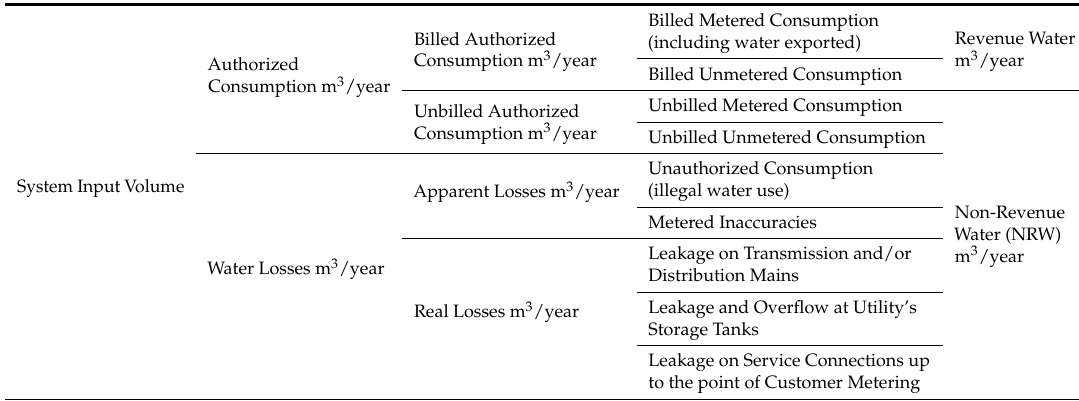
Table A1. International Water Association (IWA) Standard International Water Balance and Terminology. Adapted from